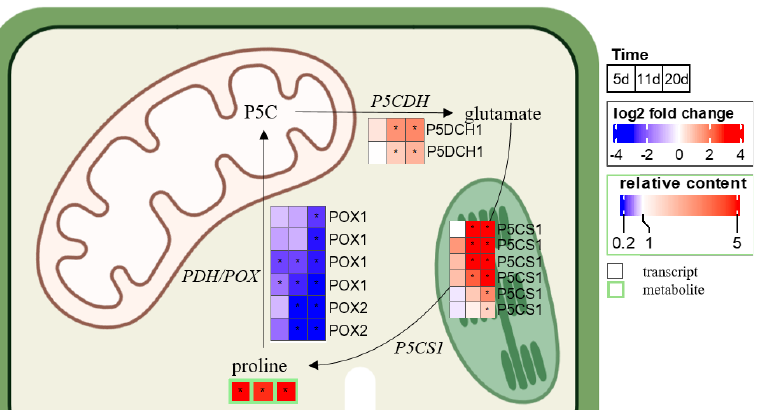
Figure 7. Log2-fold changes in DEGs and the proline content in leaves of B. napus exposed to water deficit for 5 d (mild), 11 d (severe), and 20 d (severe extended), relative to control plants. Significant variations between control and plants exposed to WD are indicated with an asterisk (*) for adjusted p -value < 0.05. P5C: pyrroline-5-carboxylate; P5CDH: delta-pyrroline-5-carboxylate dehydrogenase; P5CS1: pyrroline-5-carboxylate synthase; PDH: proline dehydrogenase; POX: proline oxidase.